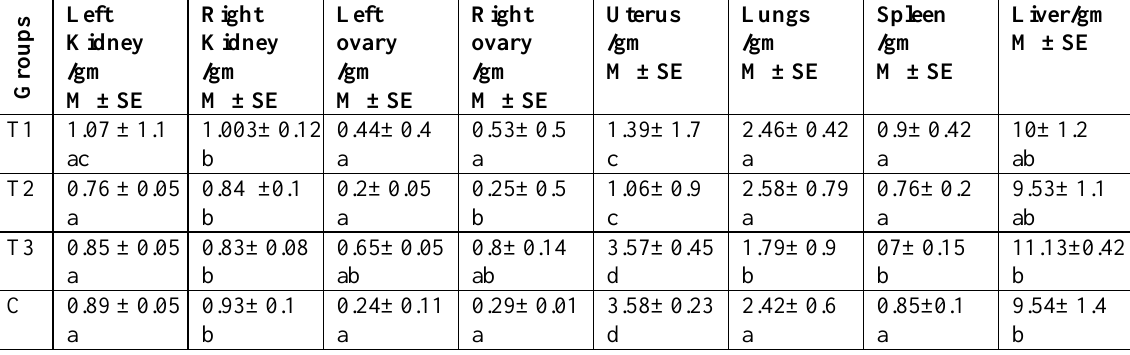
Table : 1 The organs weights of different female rats gruops ingested 10000 . IU Vit. A in different period of pregnancy